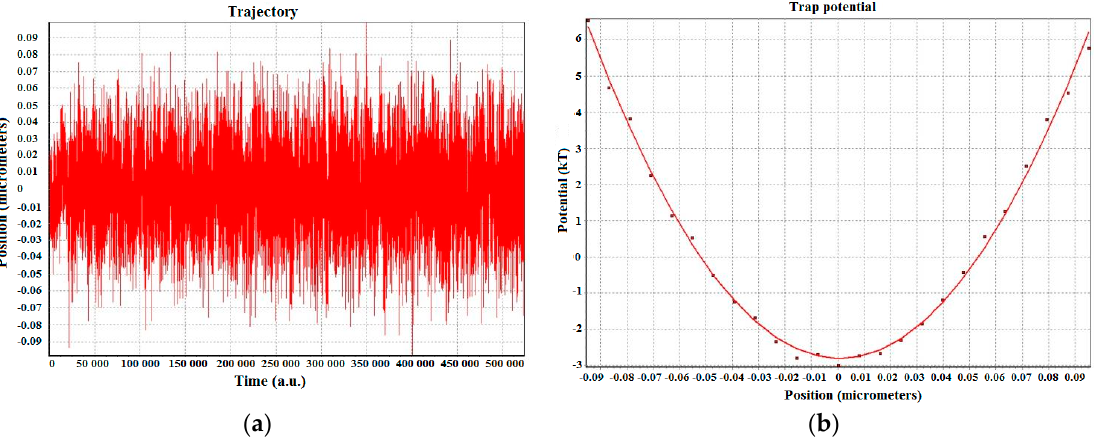
Figure 5. ( a ) Trajectory of the system of trapped silica beads and ( b ) the potential well and fit of a trapped 2 µm diameter silica bead attached to the silica bead of 4.5 µm diameter at a depth of ≈ 5.25 µm from the glass surface with trapping laser power ≈ 69.05 mW.